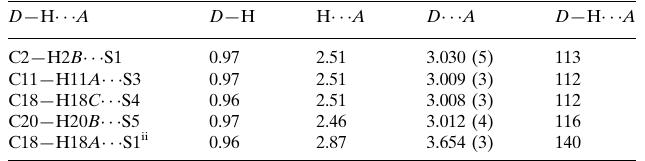
Hydrogen-bond geometry (A˚ , (cid:2)